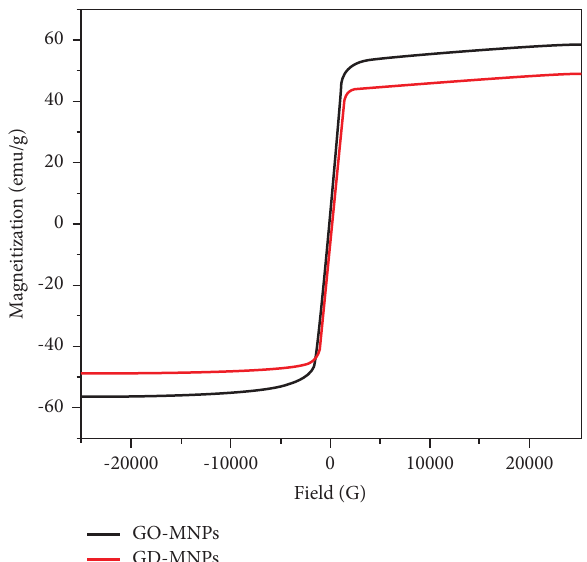
Figure 8: VSM magnetization curve of GO-MNPs and GD-MNPs.